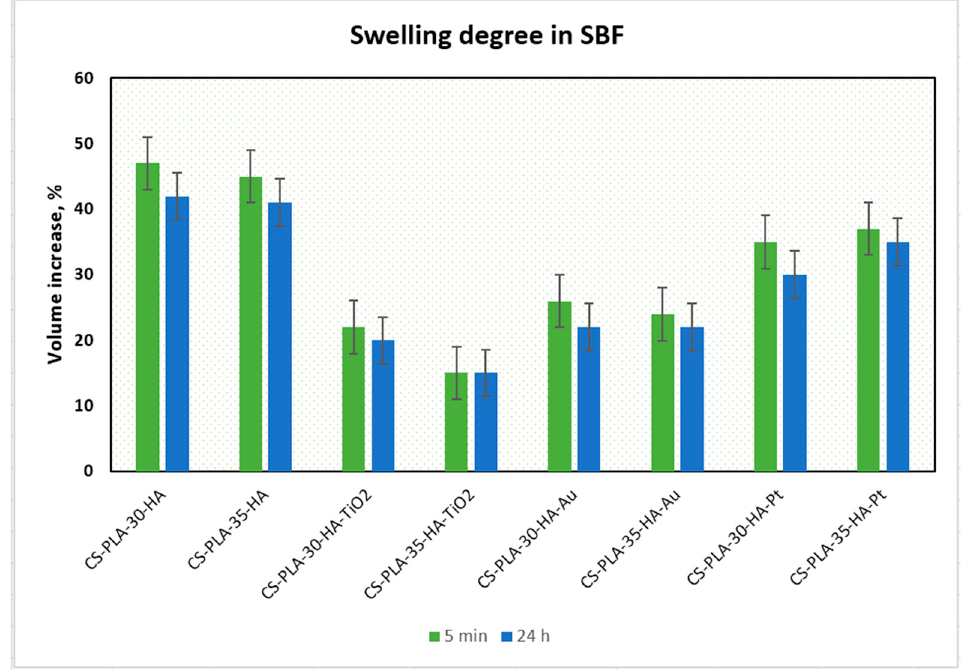
Figure 4. Swelling capacity of the prepared samples.